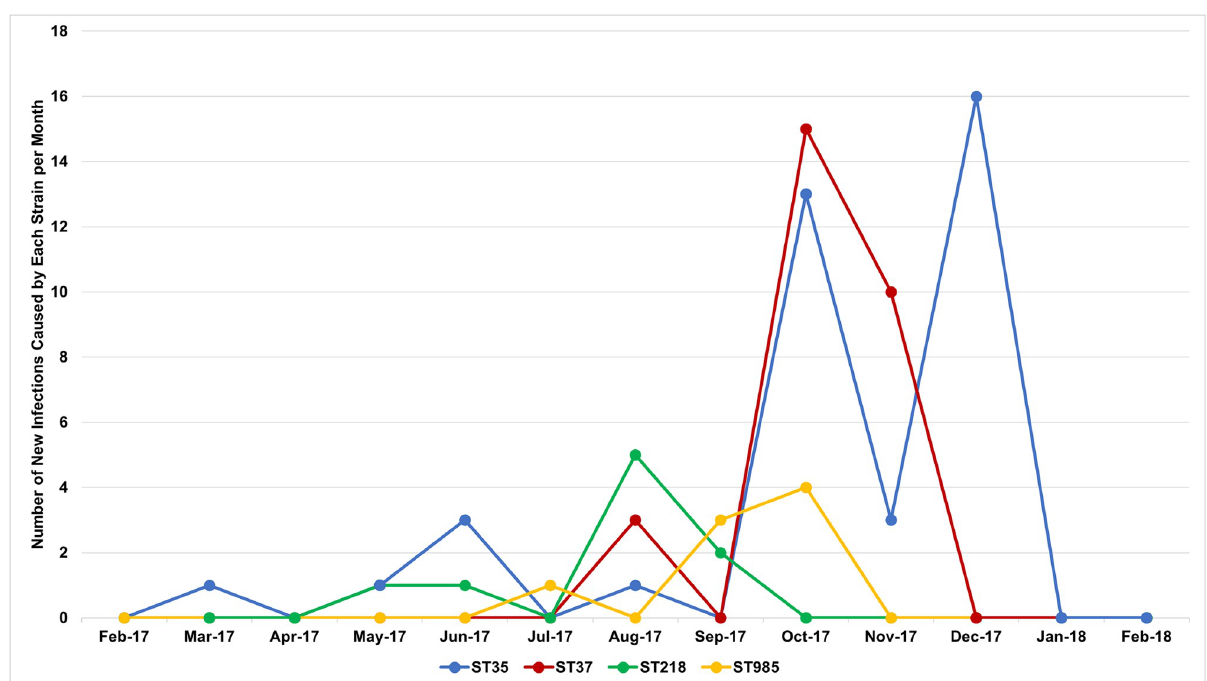
Fig 6. Seasonal timing of Klebsiella pneumoniae strains. Infections with Klebsiella pneumoniae strains, ST35, ST37, ST218, and ST985, were reported every month. Most of ST218 cases occurred between August and September; ST35 and ST37 cases occurred between October and December.